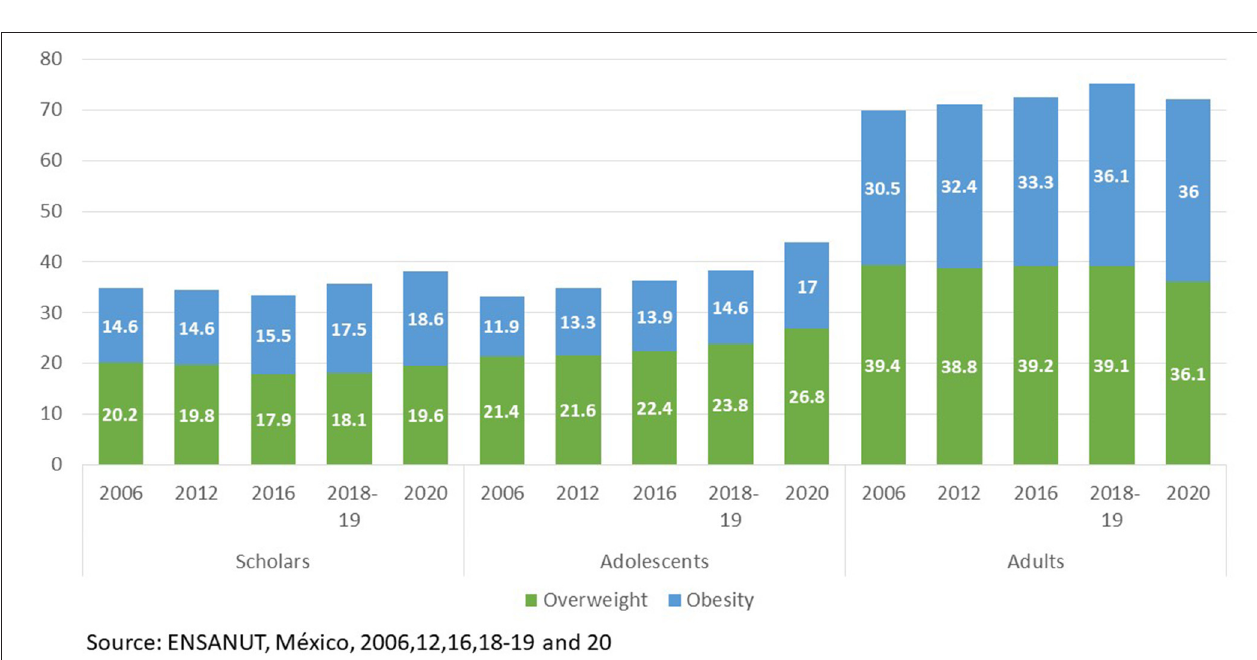
FIGURE 2 | Prevalences of overweight and obesity by age group and year survey in Mexico. Source: ENSANUT 2006, 2012, 2016, 2018–19, and 2020 .